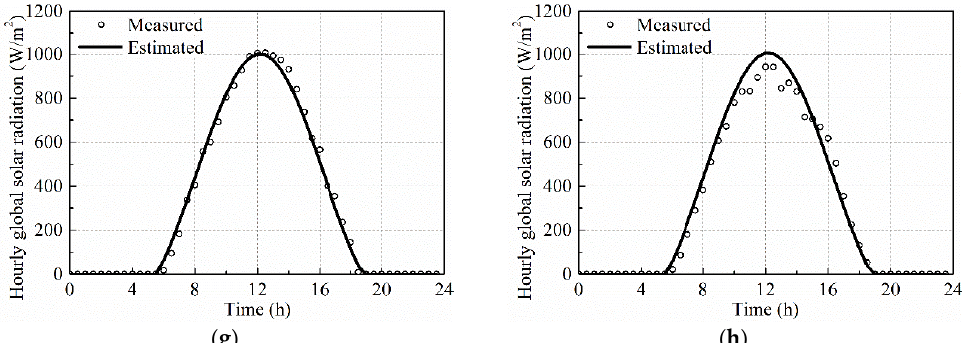
Figure 5. Comparison between measured and estimated hourly global solar radiation curves for eight cities in Fujian: ( a ) Fu’an (10 August 2016); ( b ) Jian’ou (7 August 2016); ( c ) Fuzhou (2 August 2010); ( d ) Ninghua (4 August 2016); ( e ) Zhangping (27 July 2016); ( f ) Anxi (2 August 2015); ( g ) Hua’an (30 July 2016); and ( h ) Zhangzhou (31 July 2014).